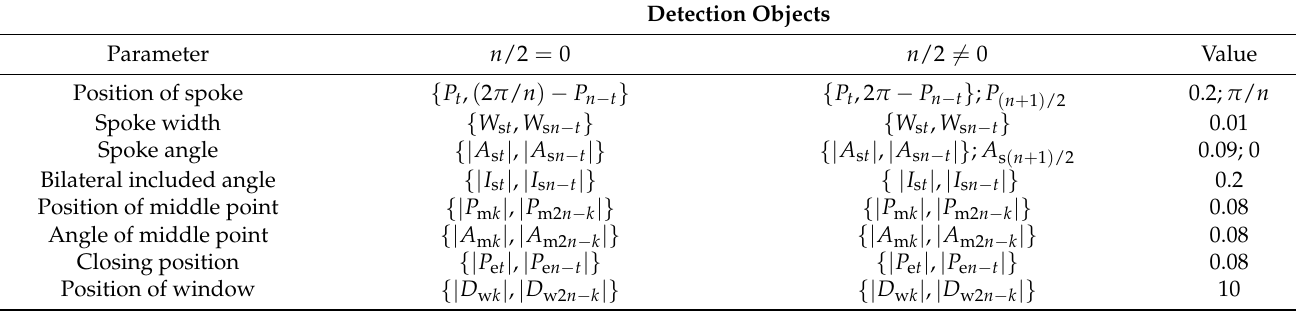
Detection Objects